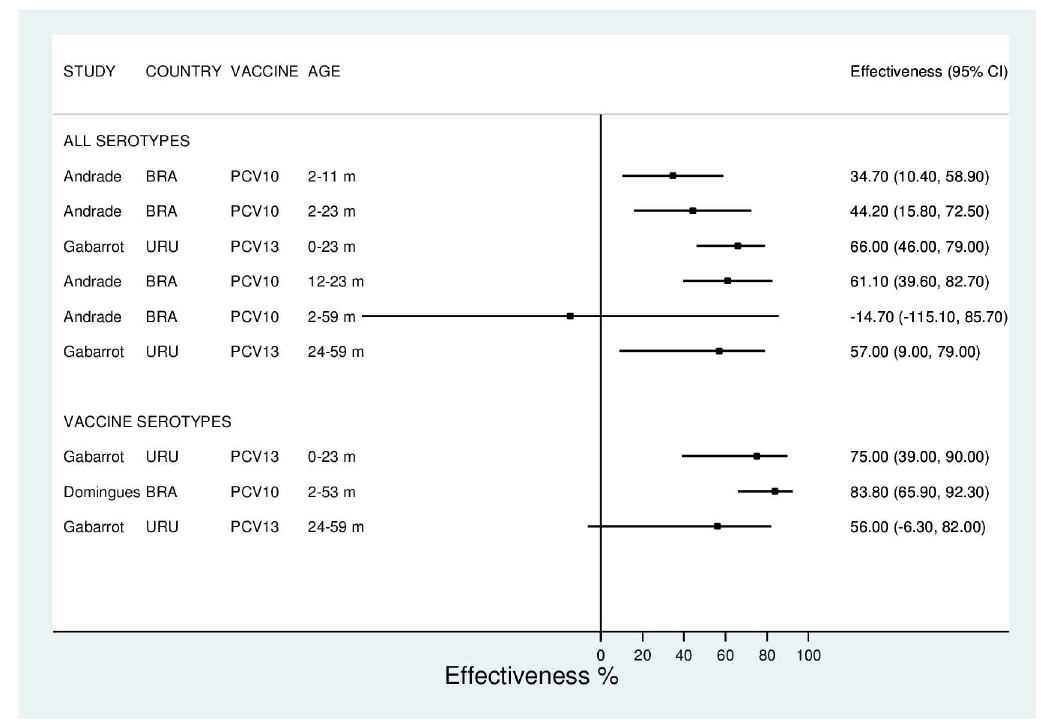
Fig 4. Vaccine effectiveness (%, 95% confidence interval * ) against invasive bacterial disease, by vaccine, group of age, vaccine serotypesand all serotypes, and hospitalization or death. * Study by Valenzuelaet al. [45] did not report confidenceinterval and was not plotted. Countries:BRA (Brazil); URU